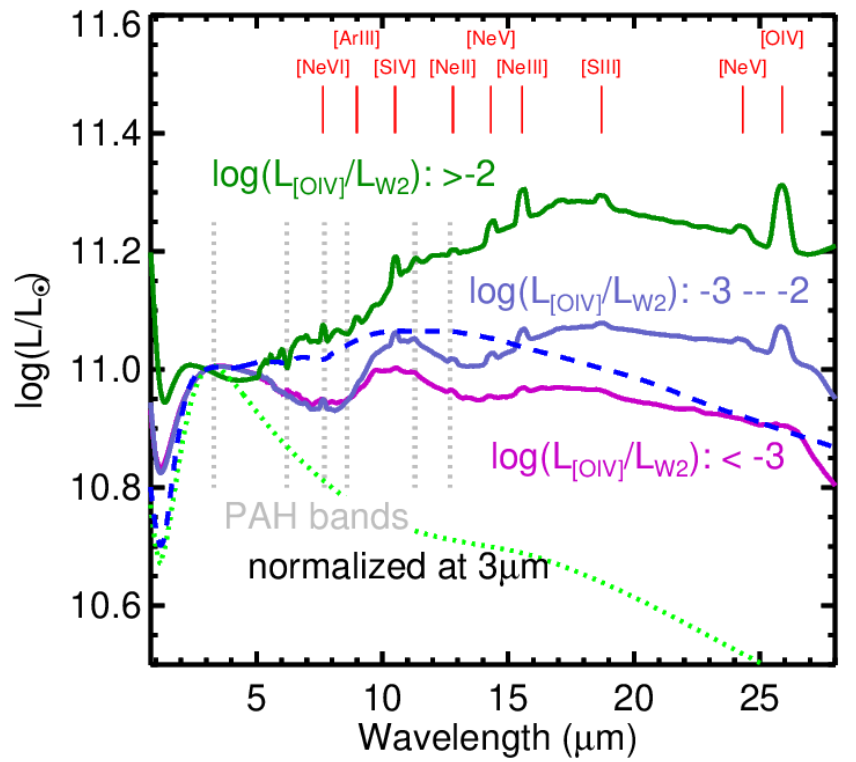
Figure 7. Average AGN mid-IR SEDs for three different bins of the luminosity in [O IV ] relative to that in W2. The green dotted line and blue dashed line represent the WDD and normal AGN templates, respectively. All these SED templates are normalized at 3 µ m. Based on Lyu & Rieke